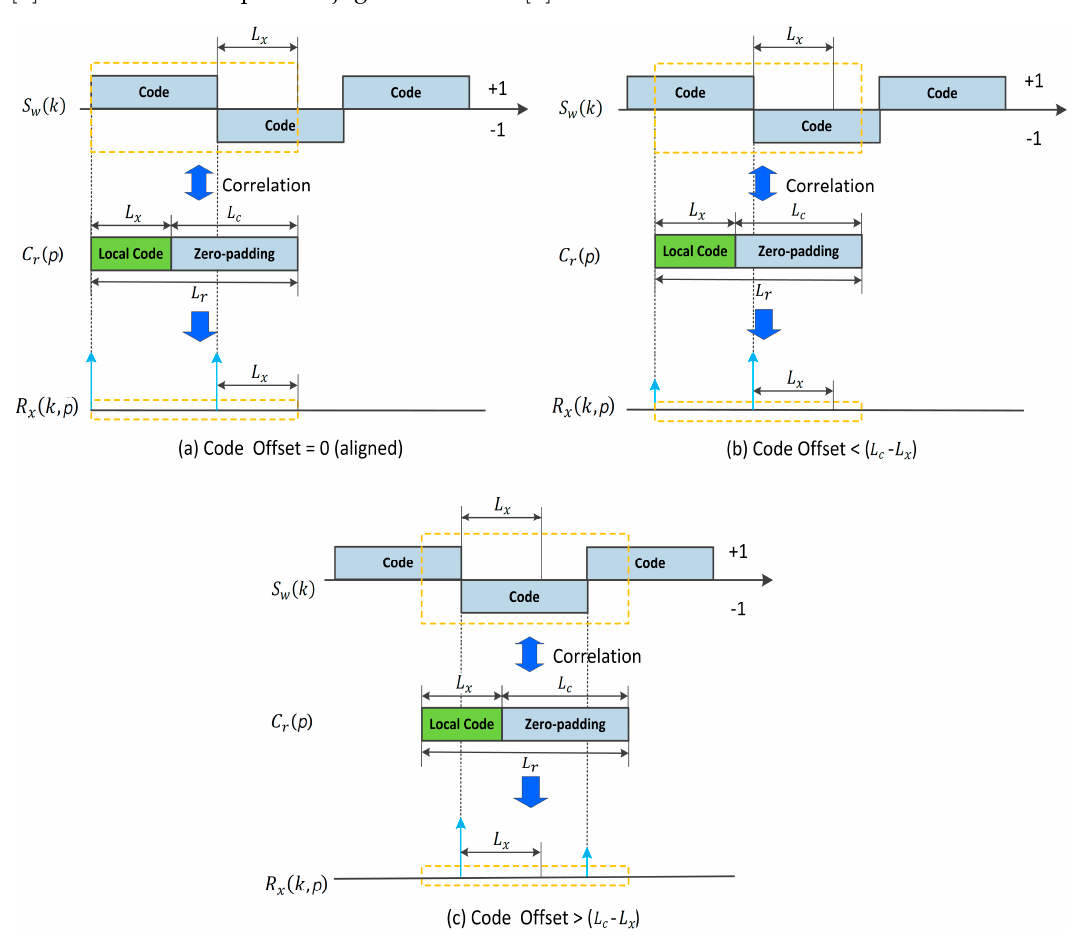
Figure 4. Circular correlation results of the baseband signal S w ( k ) and the local zero-padding code C r ( p ) : ( a ) code offset between S w ( k ) and C r ( p ) is 0 (aligned); ( b ) code offset between S w ( k ) and C r ( p ) is less than ( L c − L x ) samples; ( c ) code offset between S w ( k ) and C r ( p ) is more than ( L c − L x )